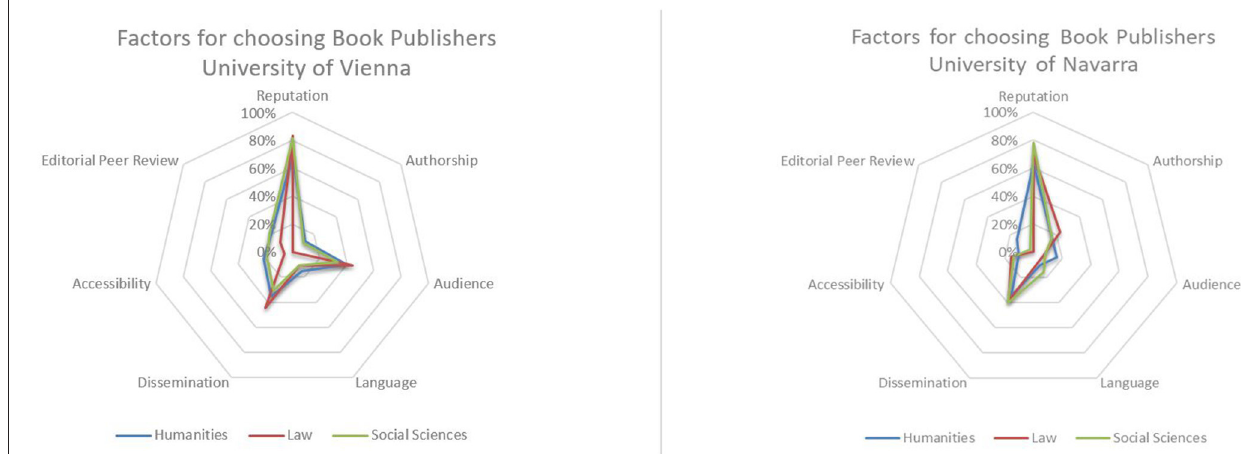
FIGURE 7 | Factors for choosing book publisher (per institution).